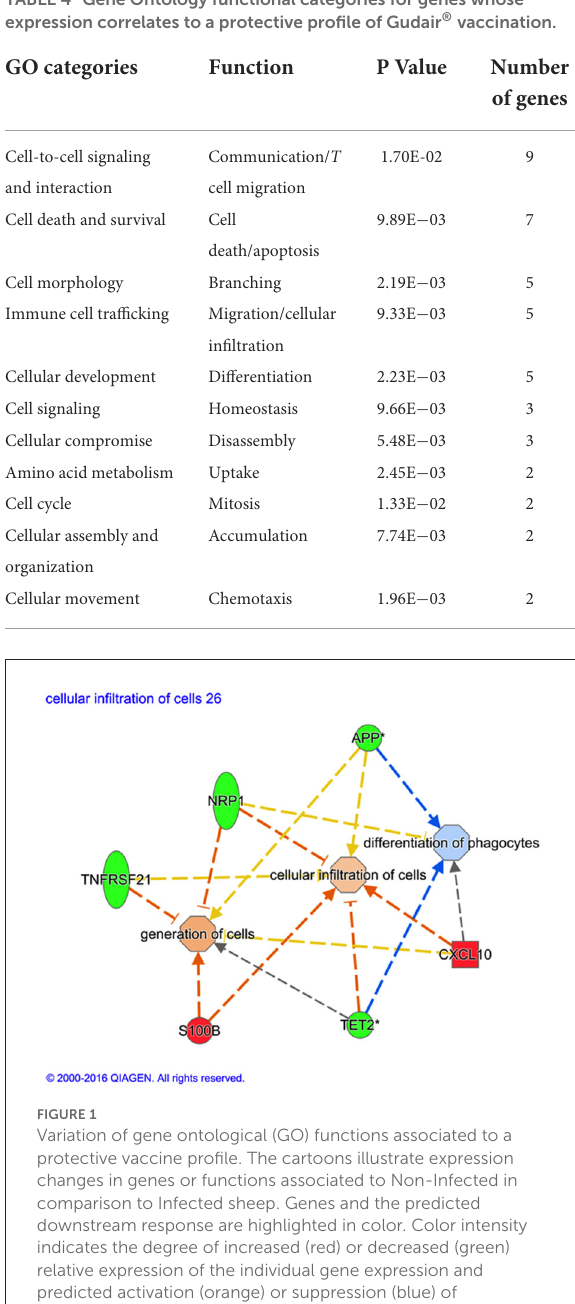
TABLE 4 Gene Ontology functional categories for genes whose expression correlates to a protective profile of Gudair ® vaccination.